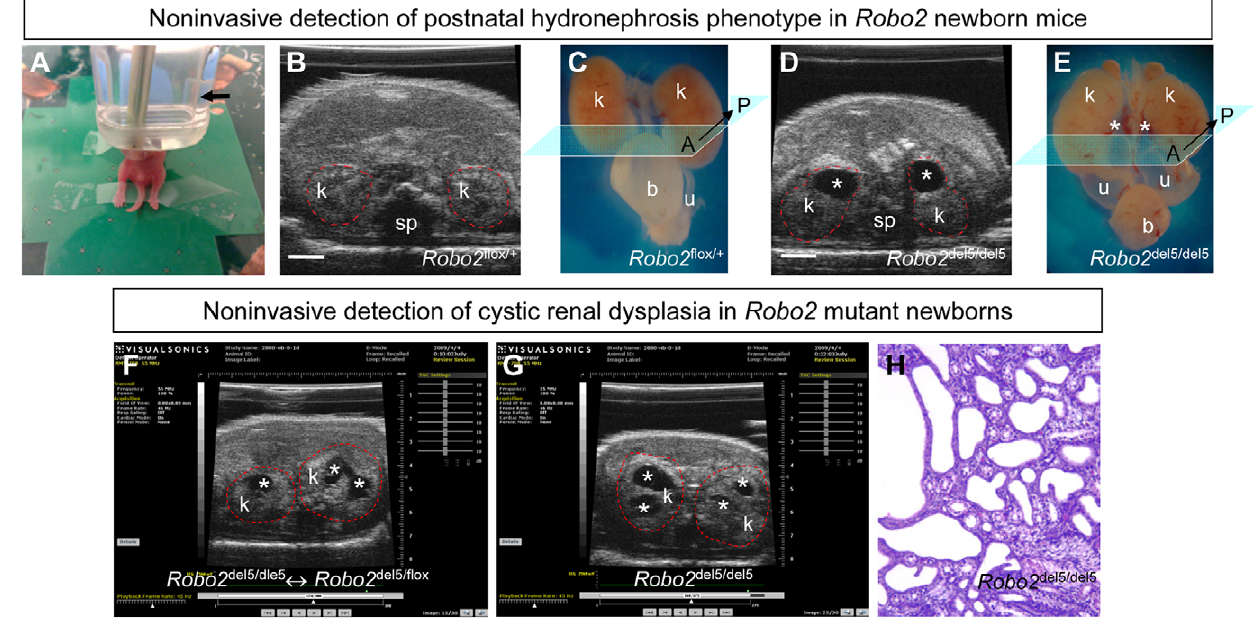
Figure 2. Noninvasive detection of postnatal hydronephrosis and cystic renal dysplasia phenotype in Robo2 newborn mice. ( A ) Ultrasound scanhead position (arrow) and a newborn mouse under anesthesia. ( B , C ) Representative ultrasound and gross structure images of wild- type normal newborn kidneys. ( D , E ) Representative ultrasound and gross structure images of Robo2 homozygous newborn kidneys with hydronephrosis (asterisks); an ideographic anterior to posterior (A R P) plane in (C,E) depicting B-mode ultrasound scanning. ( F – H ) Cystic renal dysplasia marked by multiple hypoechoic dark area (asterisks) were shown in a Robo2 mosaic newborn (F) and a homozygous newborn (G). H&E histology of cystic renal dysplasia from a Robo2 homozygous newborn was showed in (H). Scale bars, 1.0 mm. Abbreviation: b, urinary bladder; k, kidney; sp, spine; u, ureter.